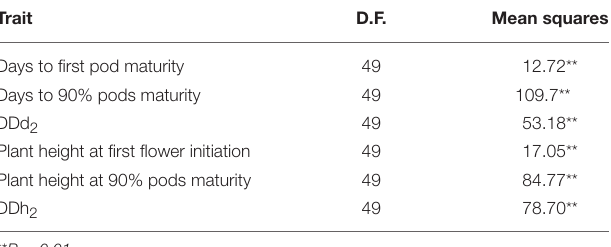
TABLE 2 | Mean squares of 50 mungbean genotypes for six traits during spring season. Trait